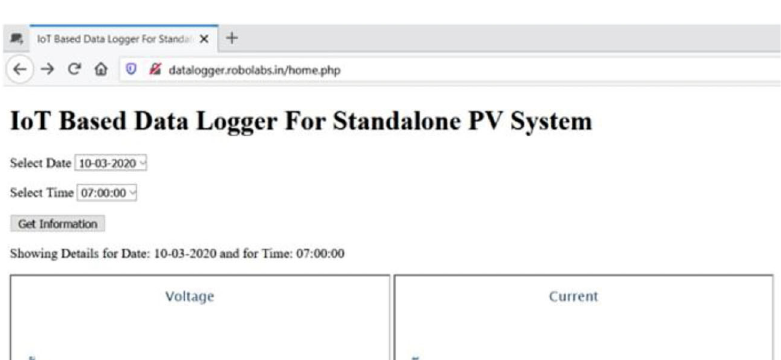
Figure 20: Comparison chart showing % MAPE.